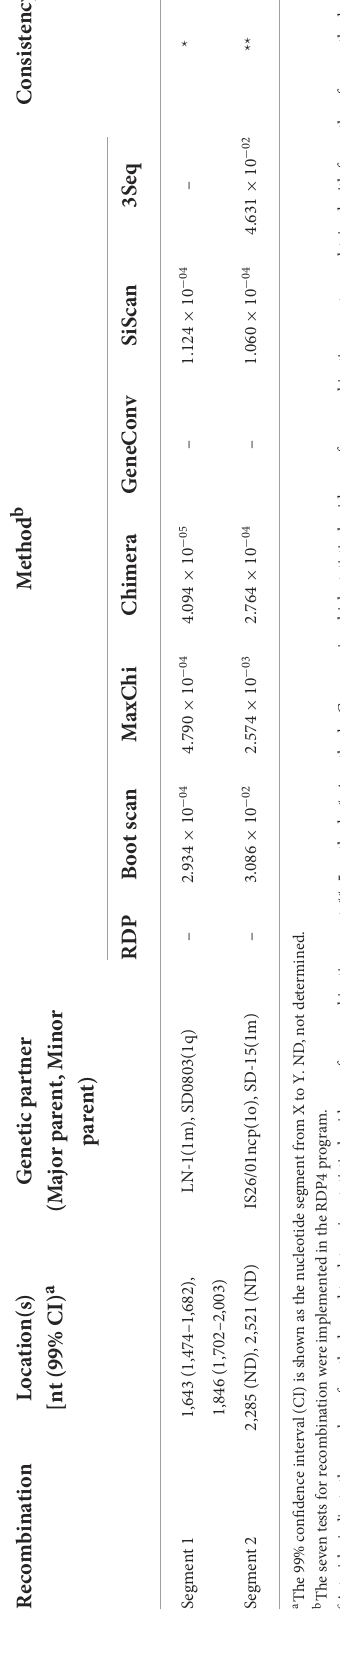
healthy calves that were negative for BVDV and other common enteric and respiratory pathogens. All animals infected with BVDV developed clinical symptoms associated with varying degrees of BVDV infection, including depression, fever, conjunctivitis, nasal discharge, coughing, and diarrhea. Compared with the calves of the control group, calves infected with BVDV showed high rectal temperatures, reaching peak rectal temperatures at 7–8 dpi (Figure 8A). Only three animals infected with BVDV-1m HB-01 strain presented obviously biphasic pyrexia, with the first peak from 4 to 5 dpi (39.5 ◦ C); while the other peak was observed from 7 to 8 dpi with a maximum record of 40.7 ◦ C. The highest rectal temperatures were noticed in the calves infected with the BVDV-1m HB- 01strain, followed by the calves infected with the BVDV-1a HN- 03 and BVDV-1v HB-03 strains. The clinical signs’ scores of the animals in each infected group reached the maximum at 7 dpi. And the clinical signs’ scores of the animals infected with the BVDV-1v HB-03 strain were lower than those of calves infected with the BVDV-1a HN-03 and BVDV-1m HB- 01 strains (Figure 8B). There were significant differences in daily weight gain between calves of the control group and calves infected with BVDV-1a HN-03 ( p < 0.01), BVDV-1m HB- 01 ( p < 0.01), and BVDV-1v HB-03 ( p < 0.05), respectively (Figure 8C). In addition, as shown in Figure 8D, one calf infected with the BVDV-1a HN-03 strain died naturally at 21 dpi.